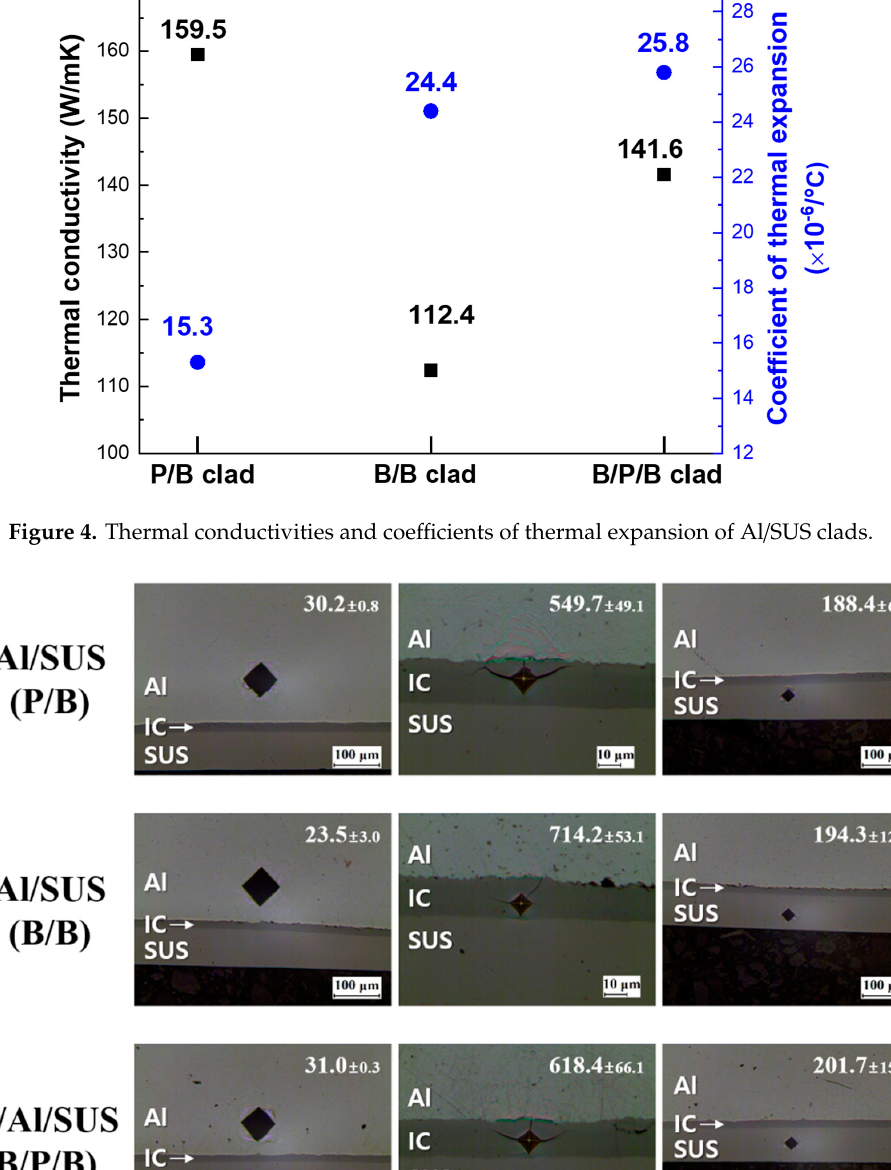
Figure 5. Vickers hardness values of Al, IC, and SUS areas in Al / SUS clads (inset average values and standard deviations of Vickers hardness).